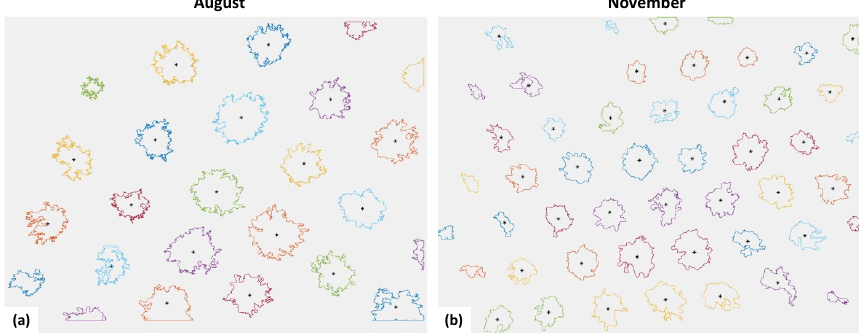
Figure 7. Identified trees for two distinct phases of the orchard: ( a ) August; and ( b ) November.